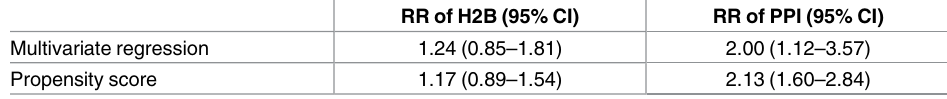
Table 3. Multivariate Regression and Propensity Score